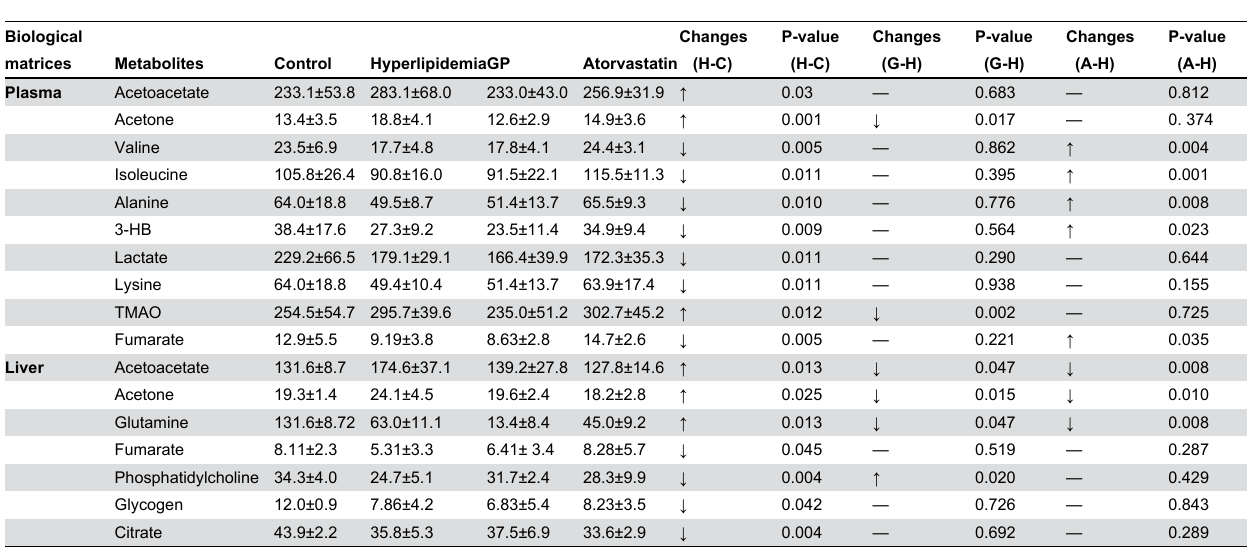
Table 2. Relative integrals from selected metabolites that contributed to the classification of the rats in the four groups.